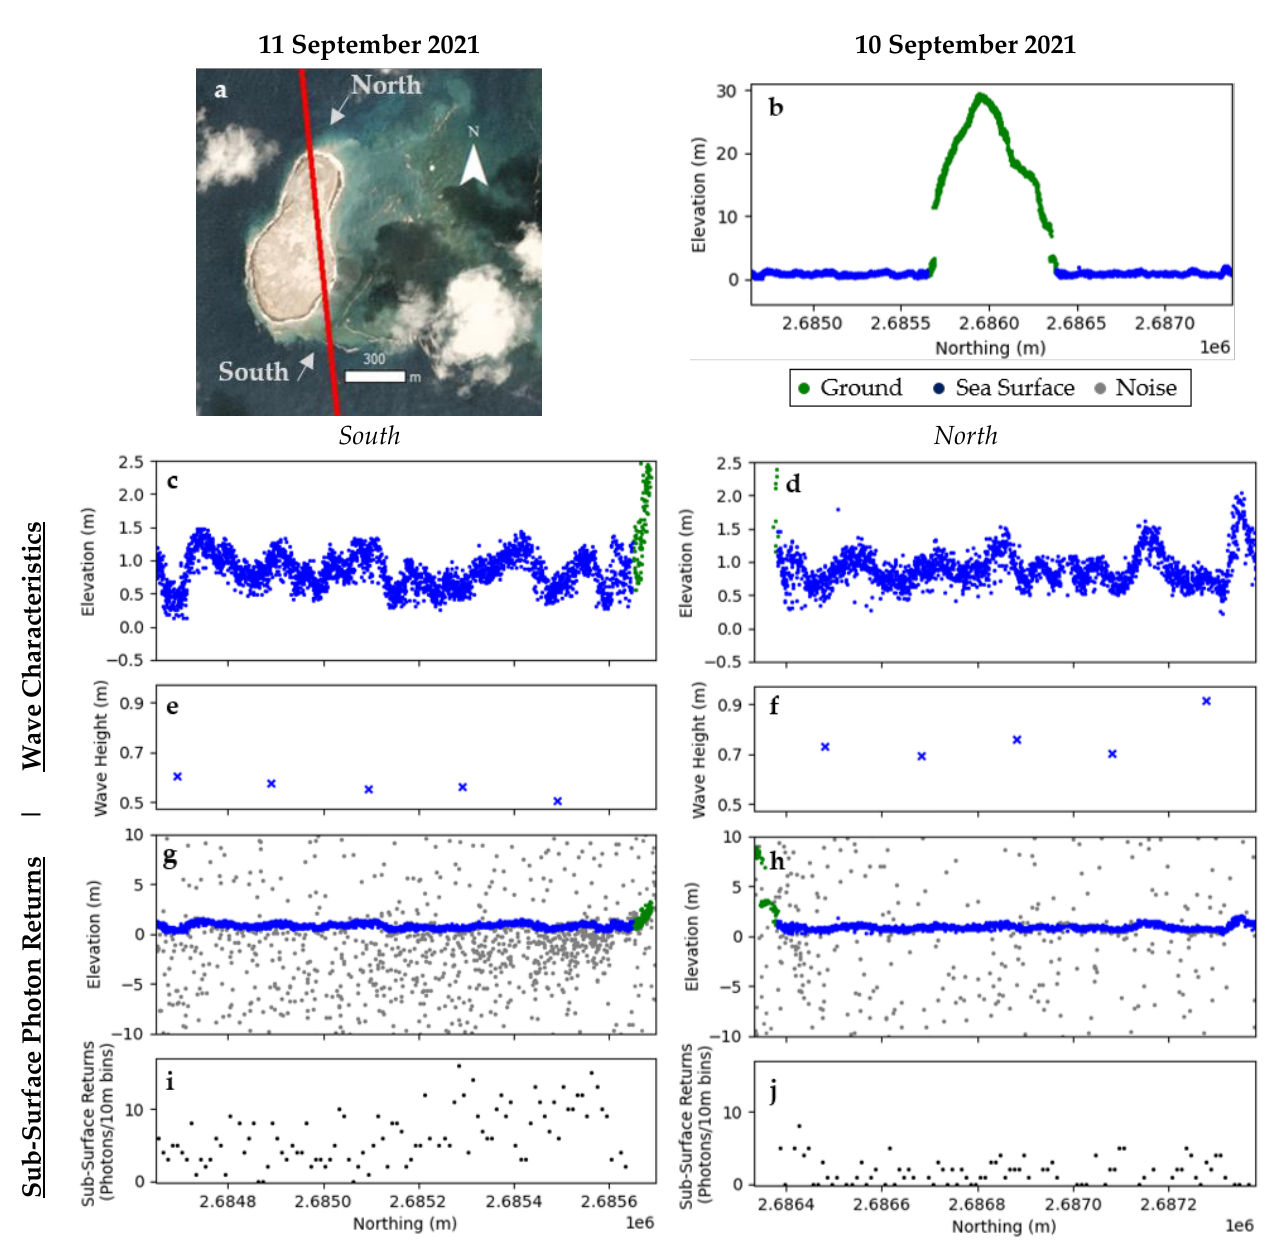
Figure 5. Planet imagery [27] ( a ) within a day of ICESat-2 lidar collection ( b ). Analysis of ‘noise’ classified photons in the water column showing the potential to investigation erosional processes occurring after the eruption. ( c,d ) Depiction of wave structure captured by ICESat-2-identified sea surface photons with ( e,f ) the average wave height per 200 m bin. The ICESat-2 product from 10 September 2021 shows an increase in unassigned photons on the south side ( g ) vs. north ( h ). The normalized sub-surface photon returns ( i,j ) per 10 m along-track bin (calculated as the difference between the number of sub-surface and above surface photons within 10 m above and below the surface) show a significantly higher concentration on the south side of the island.